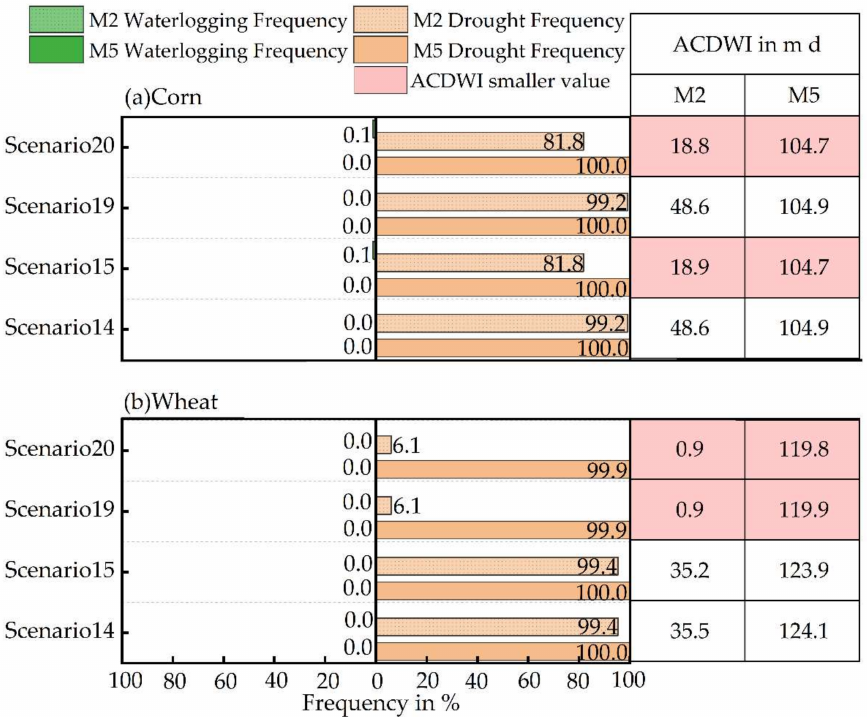
Figure 8. Drought and waterlogging stresses under different ditches’ water-depth scenarios in the middle section from 1989 to 2019, ( a ) corn growth period, ( b ) wheat growth